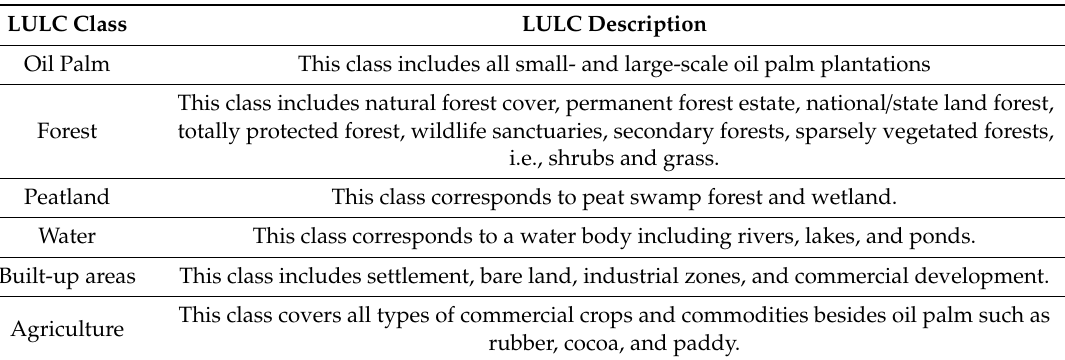
Table 2. LULC classification